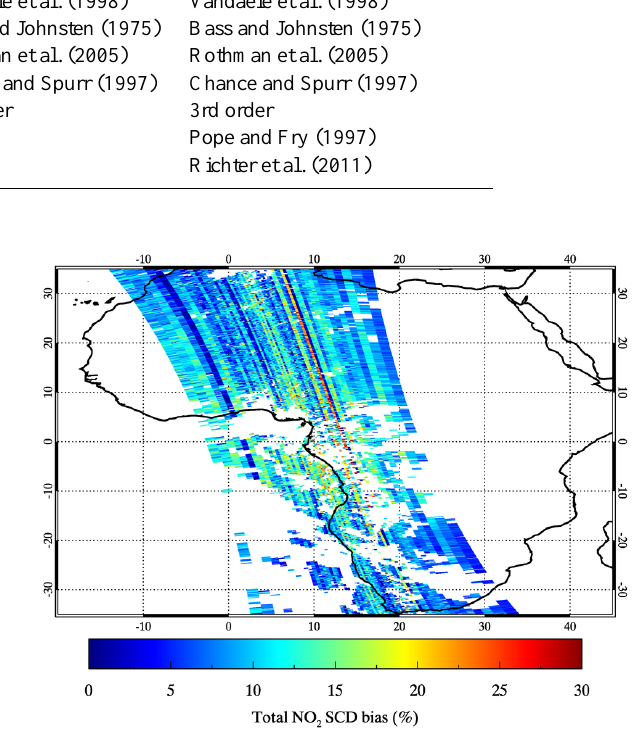
Figure 4. Average total NO 2 SCD bias between the QDOAS-based solar reference retrieval and the OMNO2A algorithm for cloud-free (cloud fraction <25%) scenes during June 2005.